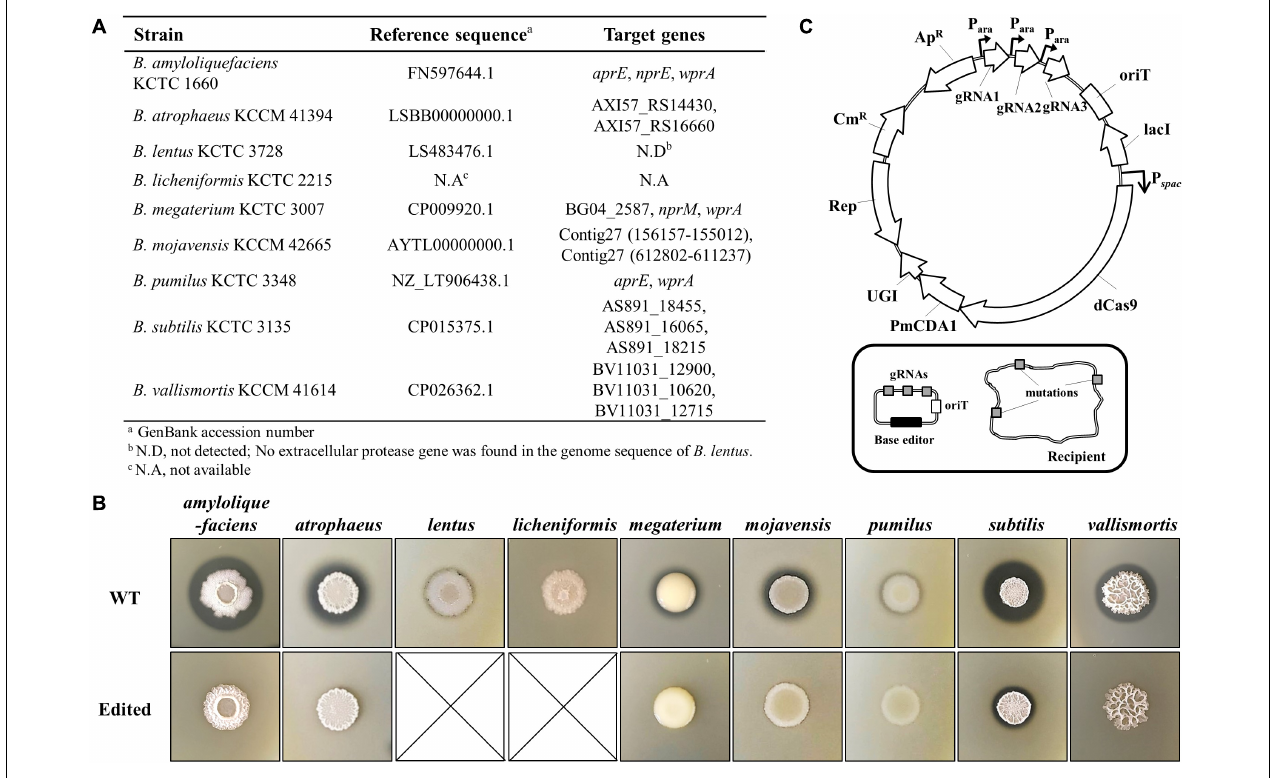
FIGURE 5 | Engineering of the QPS Bacillus strains using cytosine base editor. (A) Editing targets of the QPS Bacillus strains. In the case of B. lentus , no extracellular protease genes were found in the genome sequence. B. licheniformis used in this study did not have a genome sequence in the NCBI database. (B) The extracellular protease activity of the QPS Bacillus strains on the TSA plate containing 1% skim milk. B. lentus and B. licheniformis showed no or little extracellular protease activity. The remaining strains showed no or decreased extracellular protease activity in the edited strain compared to the WT. (C) Plasmid map for cytosine base editor-mediated multiplex genome editing. The cytosine base editor transferred by the MICE system can simultaneously edit the genome of the recipient.